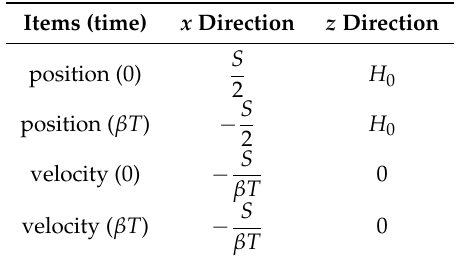
Table 3. The initial and terminated conditions of the stance